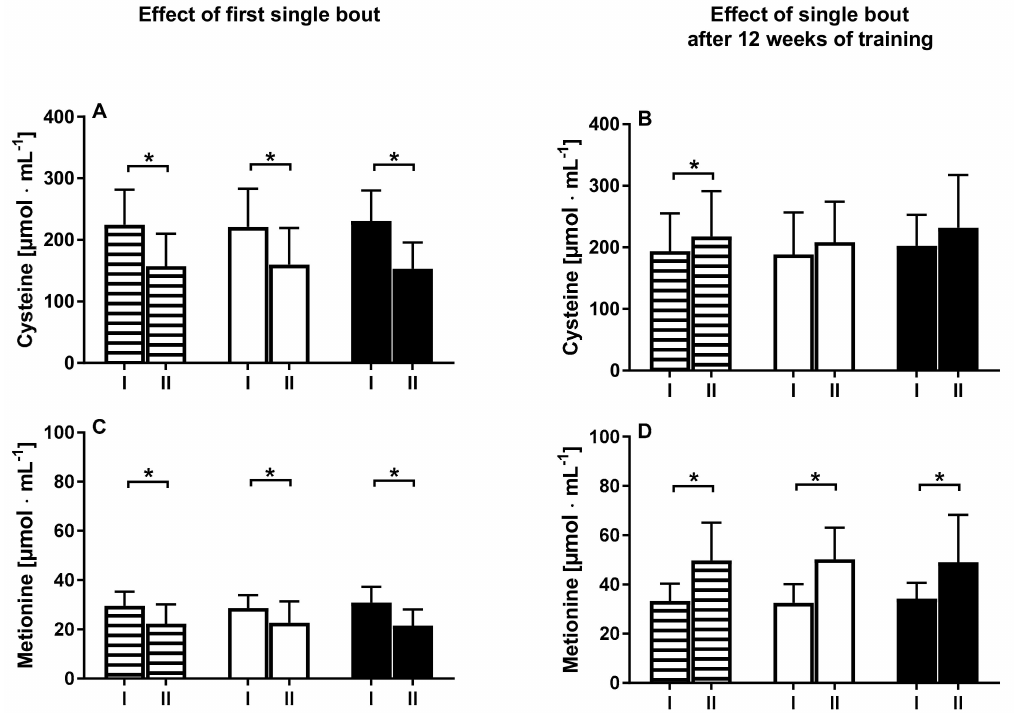
Figure 2. Changes in cysteine and methionine levels between pre (I) and 1 h after (II) exercise for all participants (white-black stripes) and subgroups with a baseline homocysteine level under 10 µ mol · L − 1 (white) and over 10 µ mol · L − 1 (black).